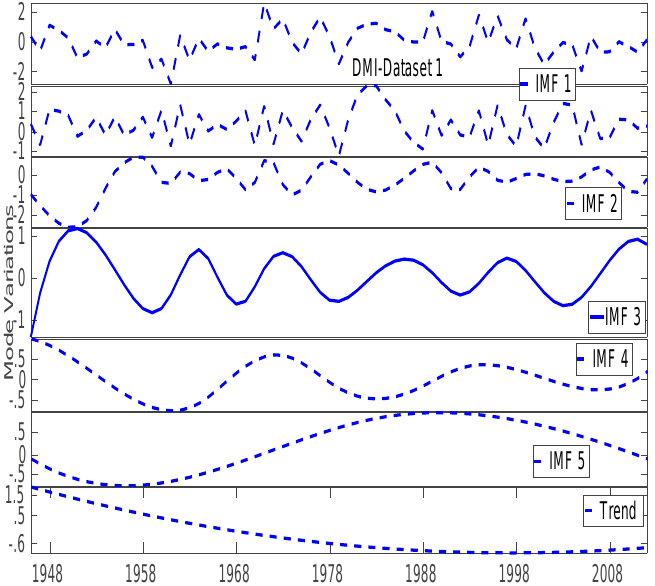
Figure 6. An EMD analysis of the DMI signal in the North Indian Ocean. The signal here is derived using the Dataset-1. The DMI signal is shown in the first panel and its monotonically increasing trend in the seventh panel. The causation modes of the signals are presented in between these two panels.